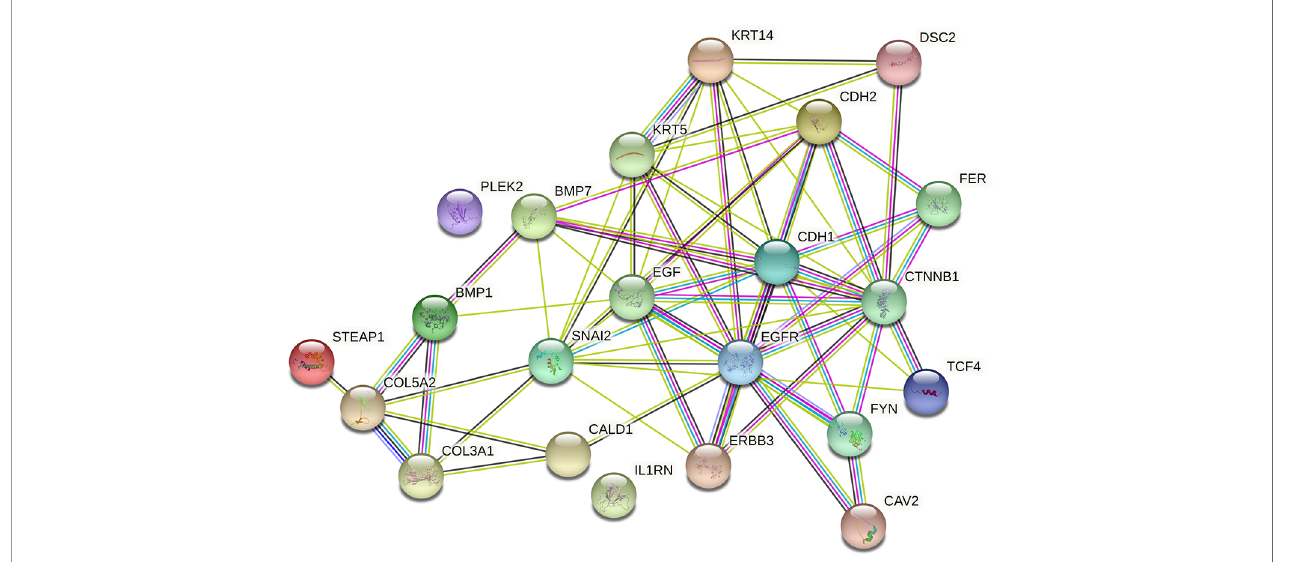
FIGURE 3 | Cluster analysis of the PPI network using STRING database for EMT proteins interactions. The network included the 22 functional partners with the highest interaction con fi dence score, namely, STEAP1, COL5A2, COL3A1, BMP1, CALD1, IL1RN, ERBB3, SNAI2, BMP7, PLEK2, CAV2, FYN, EGFR, EGF, KRT5, KRT14, CDH1, CTNBB1, TCF4, FER, CDH2, DSC2, (score ≥